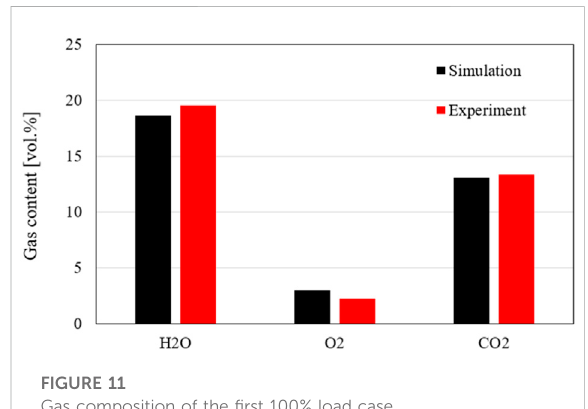
FIGURE 11 Gas composition of the fi rst 100% load case.